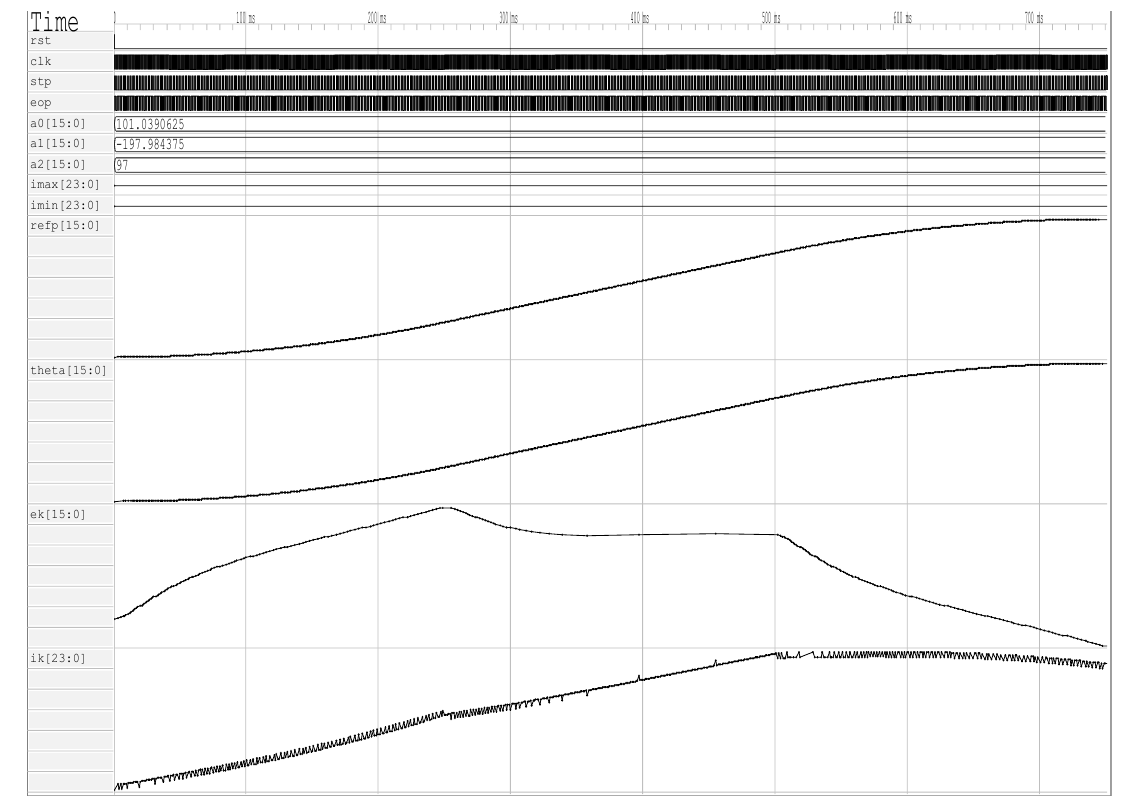
Figure 7. PID controllers simulation with open source